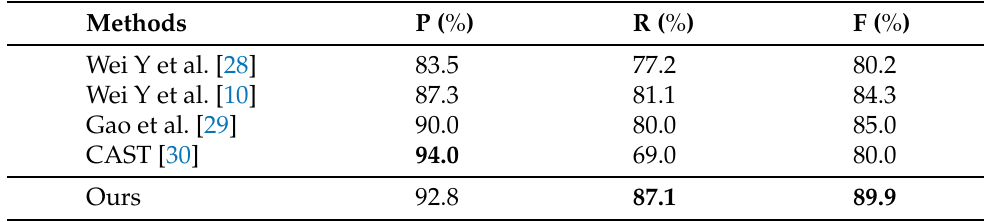
Table 3. Experimental results of various methods on the ICDAR2013